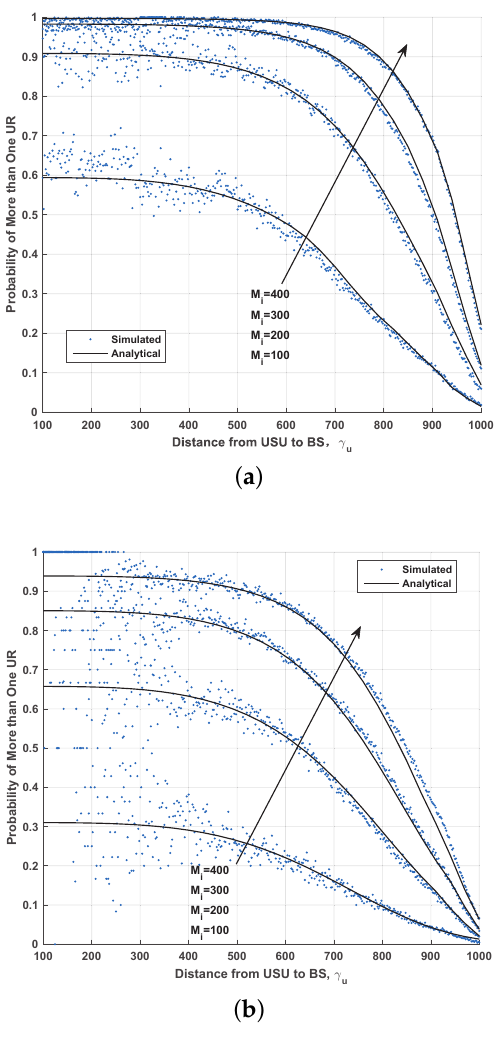
Figure 4. Probability of more than one user relay (UR) owned by USU versus the distance from him/her to base station (BS), in different number of MG users M i . ( a ): r n = 100 m, ∀ n ∈ [ 1, N ] . ( b ): r n = 75 m, ∀ n ∈ [ 1, N ]